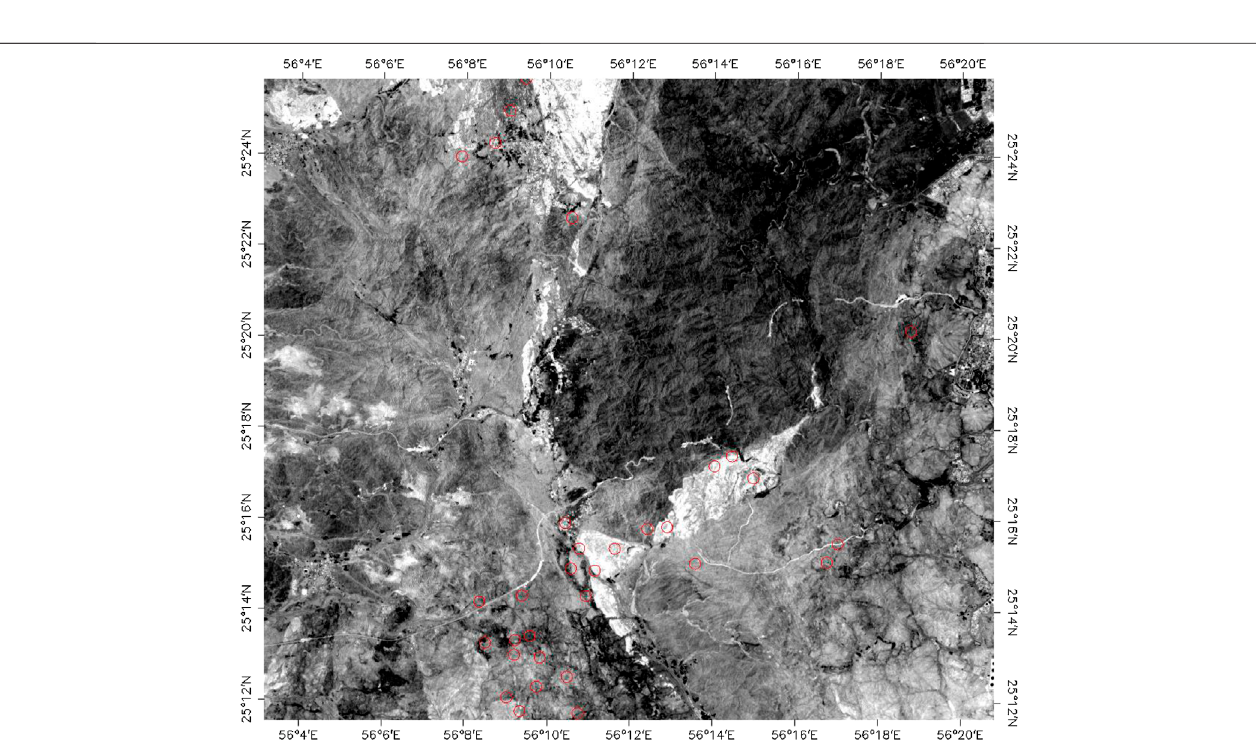
Frontiers in Earth Science |